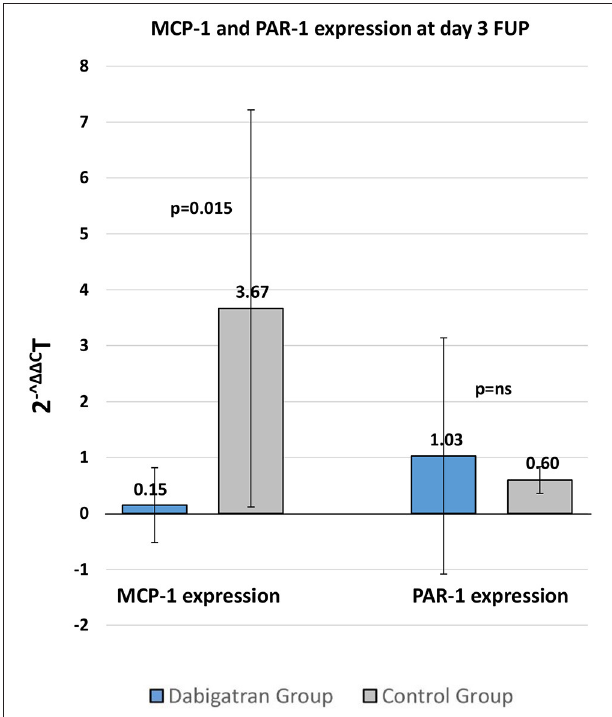
FIGURE 4 | qPCR analysis of MCP-1 and PAR-1 expression of the stented tissue 3 days after stenting in dabigatran and control groups. Mean ±